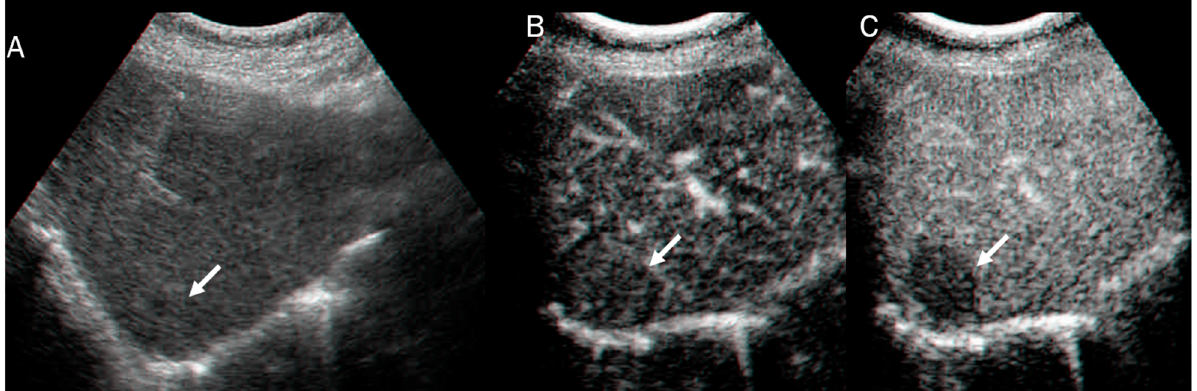
Figure 3. US and CEUS assessment of ICC: On US ( A ), the lesion (arrow) shows iso-hypoechoic pattern compared to hepatic parenchymal. During arterial phase ( B ), the lesion shows arterial hyperenhancement (arrow), with washout (arrow) in portal phase ( C ).